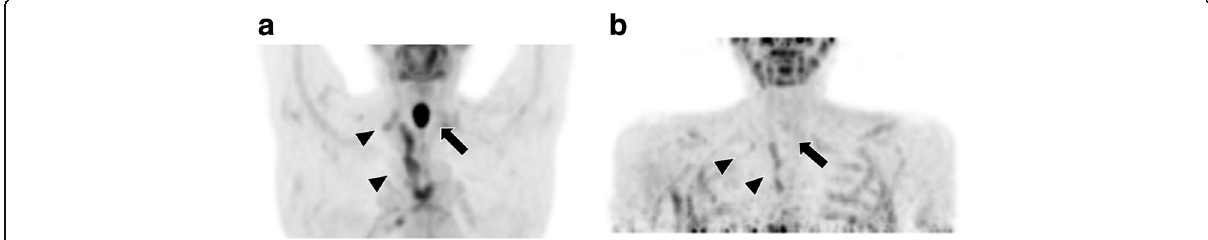
Fig. 3 FDG-PET/CT images obtained before ( a ) and after ( b ) chemotherapy in case 2. a Images obtained before chemoradiotherapy show FDG accumulation in the primary cancer (arrow; SUV max: 23.1) and in the mediastinal lymph nodes (arrow head; SUV max: 5.45). b Images obtained after chemotherapy show a disappearance in FDG uptake in the primary cancer (arrow) and a slight reduction in FDG uptake in the mediastinal lymph nodes (arrow head; SUV max: